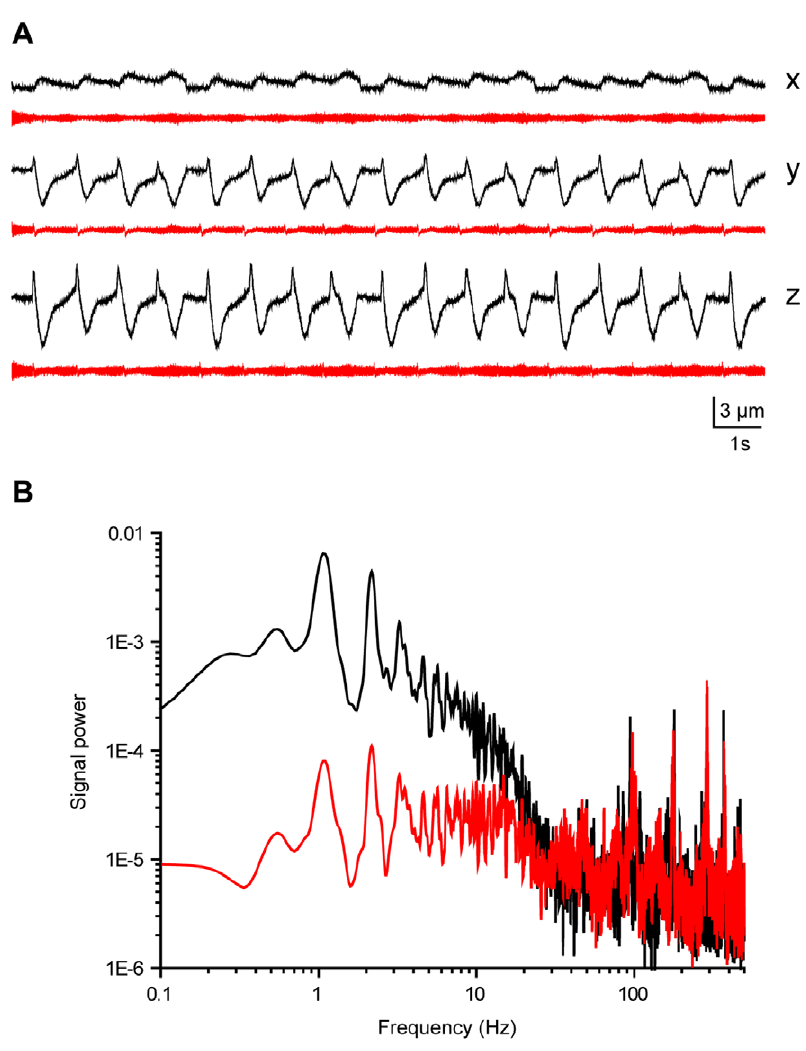
Figure 7. 3D stabilization of the brain derived micromotion sequence. A, Movement relative to the sensor tip before (black) and after the stabilization compensation (red) for each of the axis. B, Power spectrum of the z-axis data in A.